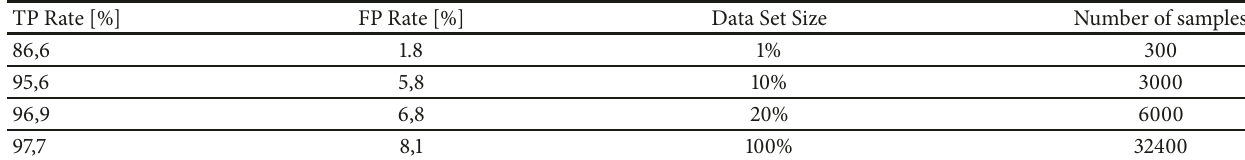
Table 2: True positive rate and false positive rate for different numbers of learning